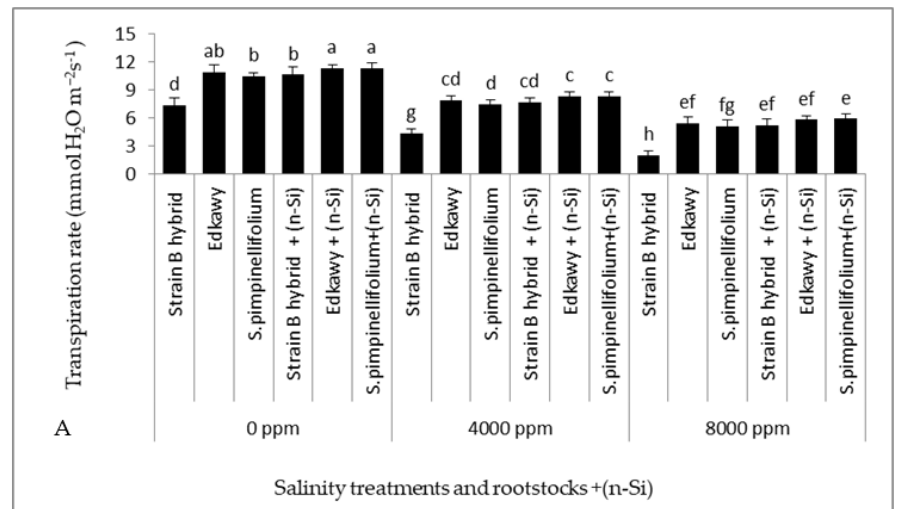
Figure 2. Effects of water salinity levels × rootstocks and foliar spray with (n ‐ Si) interaction on ( A